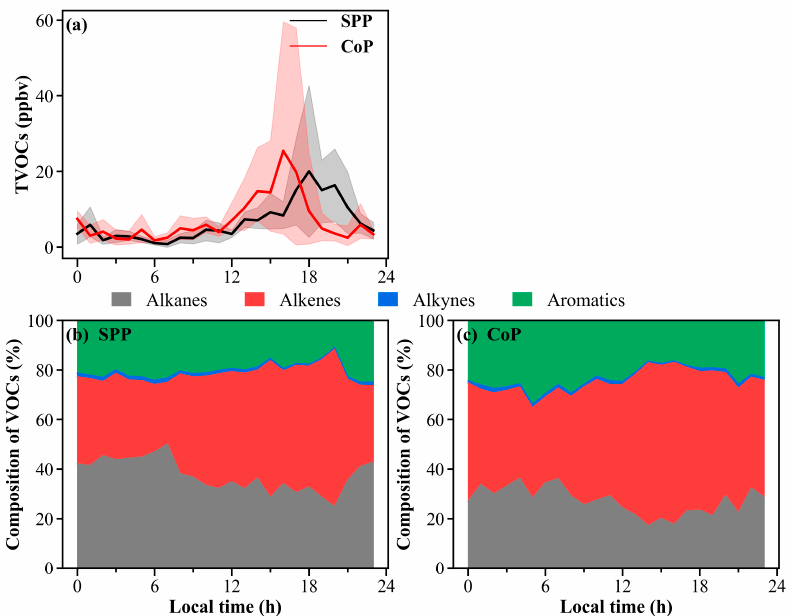
Figure 8. Concentration ( a ) and composition ( b , c ) of consumed VOCs in different pollution epi- sodes. The error line on each bar corresponds to the standard deviation.